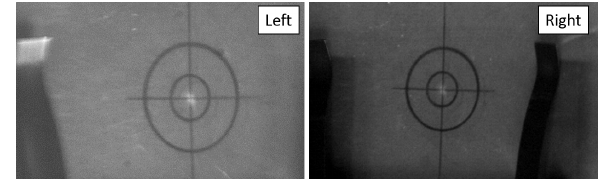
Figure 4. Semi-transparent cross-hairs used to define the experiment shot axis in world coordinates. A laser shinning along the shot axis is used to position the cross-hairs. Multiple points are measured to define the line.